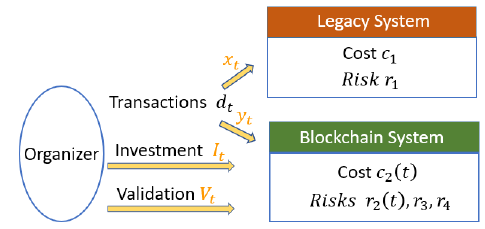
Figure 4. Organizer’s